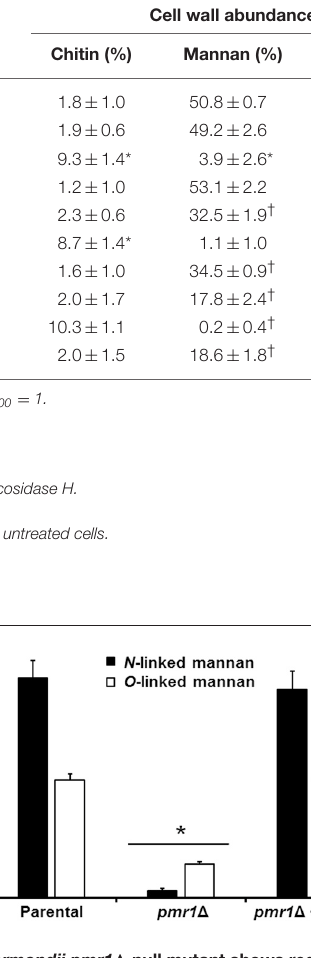
TABLE 1 | Cell wall analysis of Cg pmr1 1 null mutant and control strains. Strain Cell wall abundance